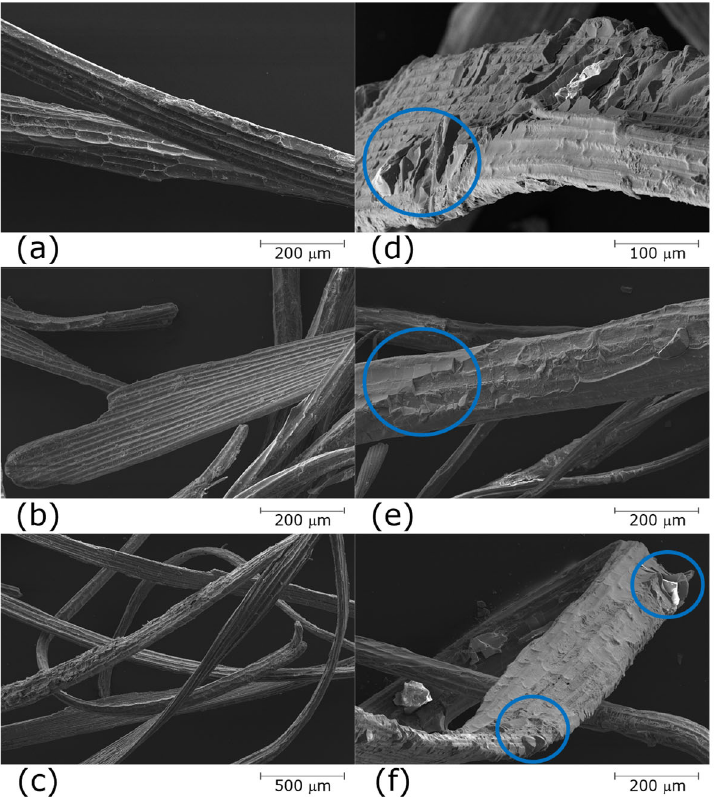
Figure 2. SEM images of POF ( a – c ) and POF/TiO 2 ( d – f